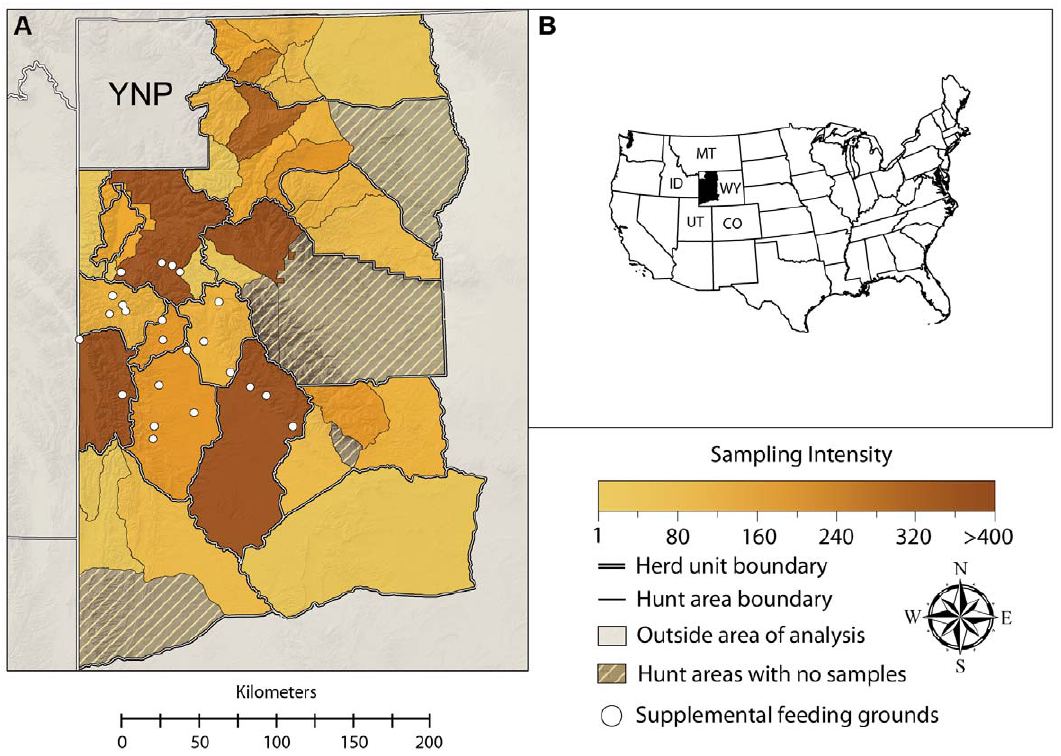
Figure 1. Map of the study area. In (A), the shading indicates the intensity of brucellosis testing among adult female elk in each hunt area. Broad and fine scale spatial analysis units (herd units and hunt areas, respectively) are shown along with the location of the 23 supplemental feeding grounds. Hashed regions did not have any disease test results. (B) The location of the study area within the United States.